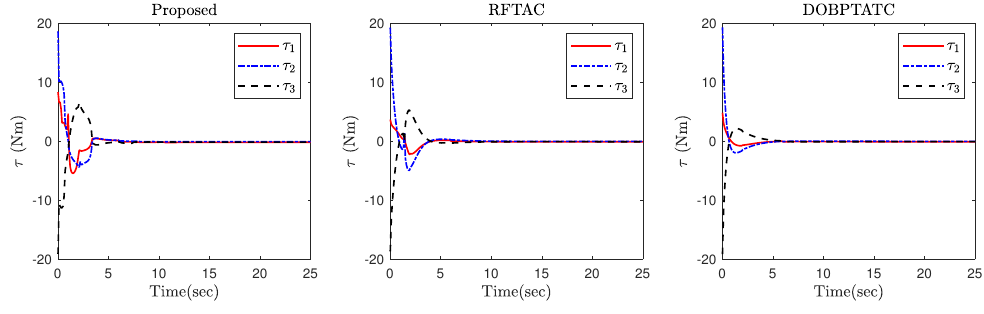
Figure 14. The control input in Part 3.